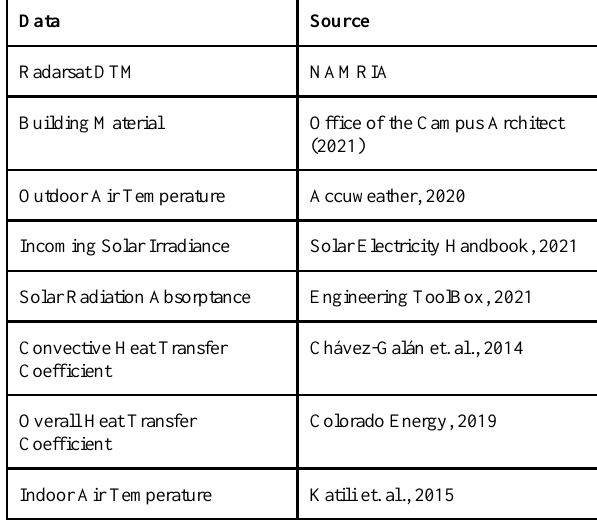
Table 1. List of acquired